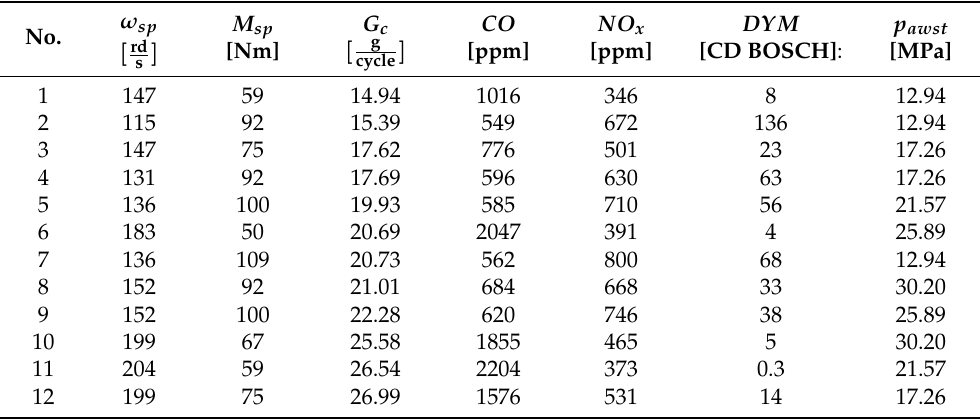
Table 3. Parameters of combustion engine duty points determined for accumulator with capacity V a = 0.01 [m 3 ] (load